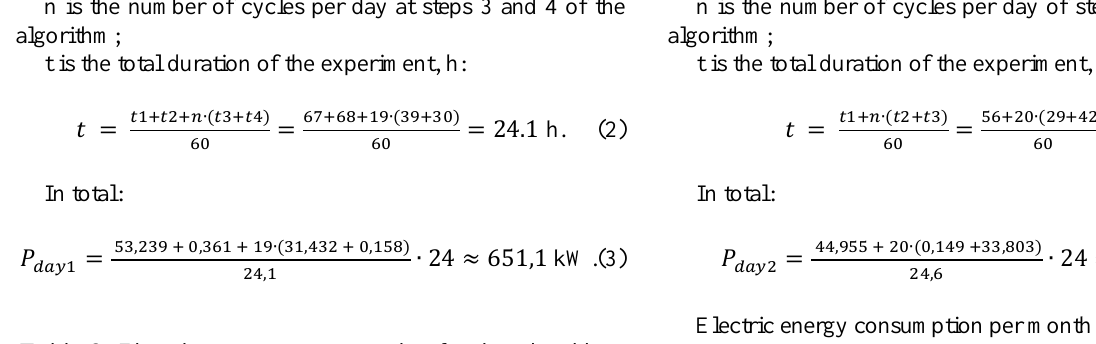
Table 2. Electric energy consumption for the algorithm of the 1 st option of the ECAH operation mode